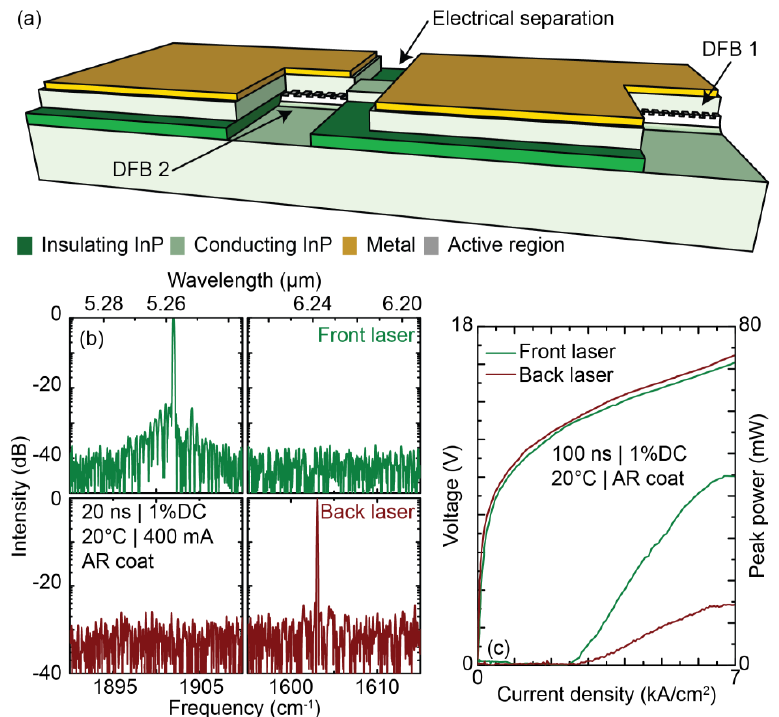
Figure 9. Dual-section DFB QCLs. ( a ) Schematic illustration of a dual-section DFB QCL revealing the two separate DFB gratings as well as the electrically separated top contact allowing for individual electronic control of the two laser wavelengths; ( b ) laser spectra of both section of a dual-section DFB QCL, operated individually; and ( c ) light-current-voltage characteristic of both sections of a dual-section DFB QCL individually operating at the wavelengths shown in ( b ).